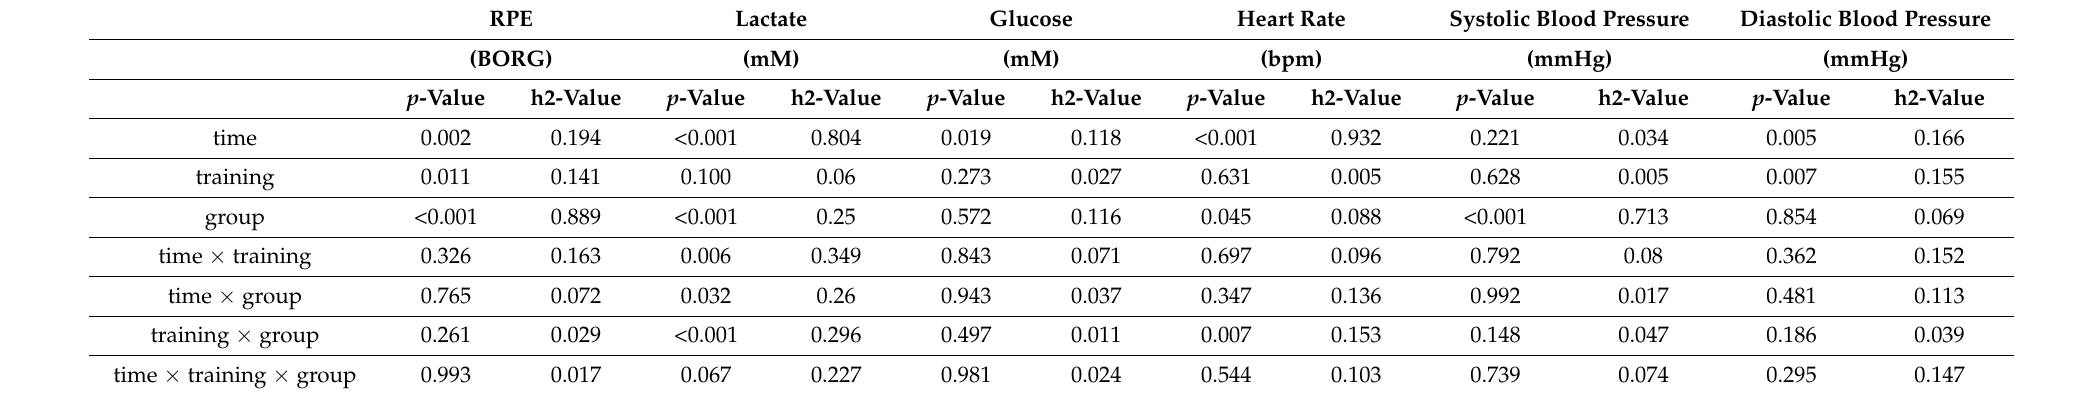
Table 6. Training-induced alterations in the cardiovascular/metabolic response during ramp exercise. p - and h2-value for the single and interaction effects of ‘training’ (pre/post) × contraction ‘group’ (concentric/eccentric) for time-related alterations of cardiovascular parameters during the ramp test of cycling exercise to voluntary exhaustion. Repeated-measures ANOVA with post-hoc test of least significant difference. The p -values for effects that were deemed significant are